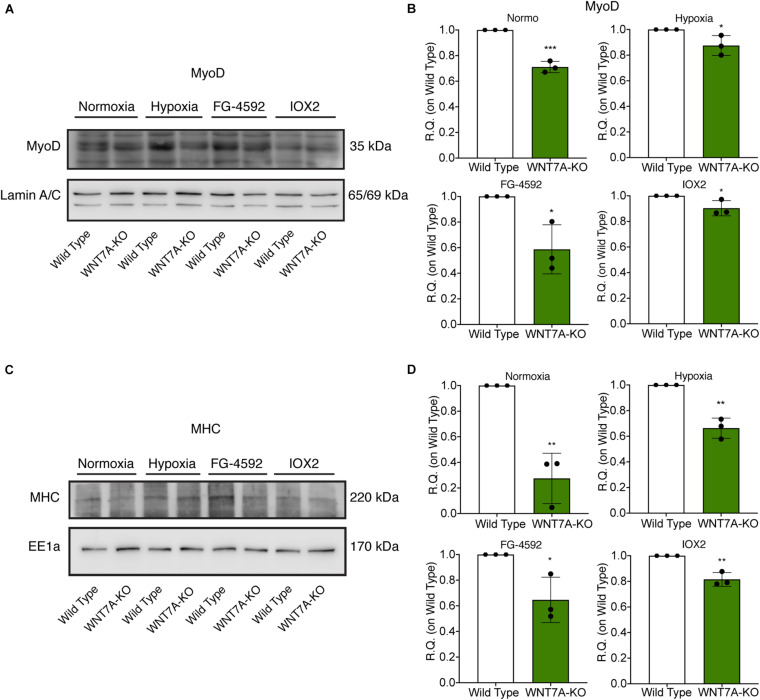
Modulation of MyoD nuclear translocation and myosin heavy chain (MHC) expression in wild type (WT) and WNT7A-silenced murine myoblasts upon physical and pharmacological hypoxia. (A,B) Western blot analysis (A) and relative quantification (B) of MyoD nuclear localization were tested after 24 h preconditioning under physical or chemical hypoxia in WT and WNT7A-KO. The nuclear marker Lamin A/C was used as the housekeeper (n = 3). (C,D) Western blot analysis (C) and relative quantification (D) of MHC were measured at the end of the skeletal muscle differentiation in WT and WNT7A-KO. The early endosomal antigen 1a (EE1a) was used as the housekeeper (n = 3). Data information: all data represent mean ± SD. *p < 0.05, **p < 0.01, ****p < 0.0001 (Student’s t-test).